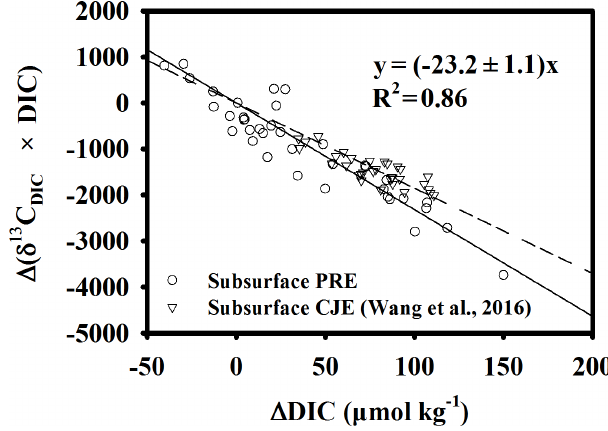
Figure 8. (cid:49) ( δ 13 C DIC × DIC) vs. (cid:49) DIC in the PRE. Samples were collected from subsurface water ( > 5m). (cid:49) is the difference between the field-observed and conservative values. Also shown are data from the Changjiang Estuary (CJE) reported by Wang et al. (2016). The straight and dashed lines indicate linear regression lines of data from the PRE and CJE, respectively. The regression equation is shown for the